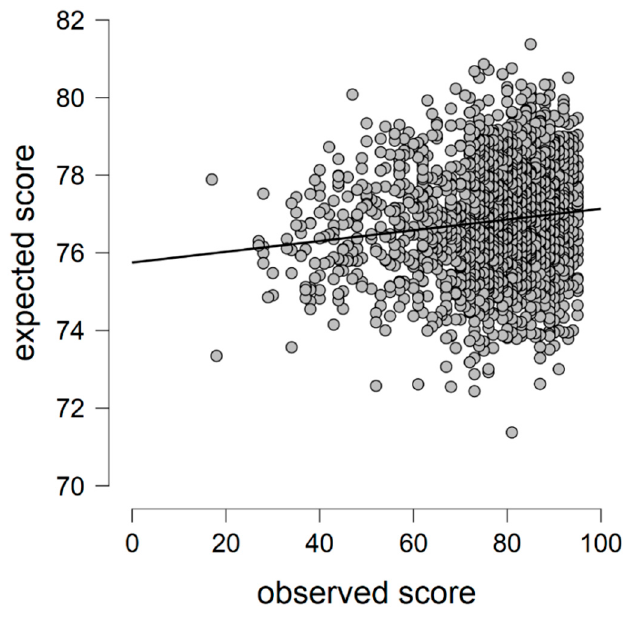
Figure 4. Observed point score and expected point score scatter-plot.